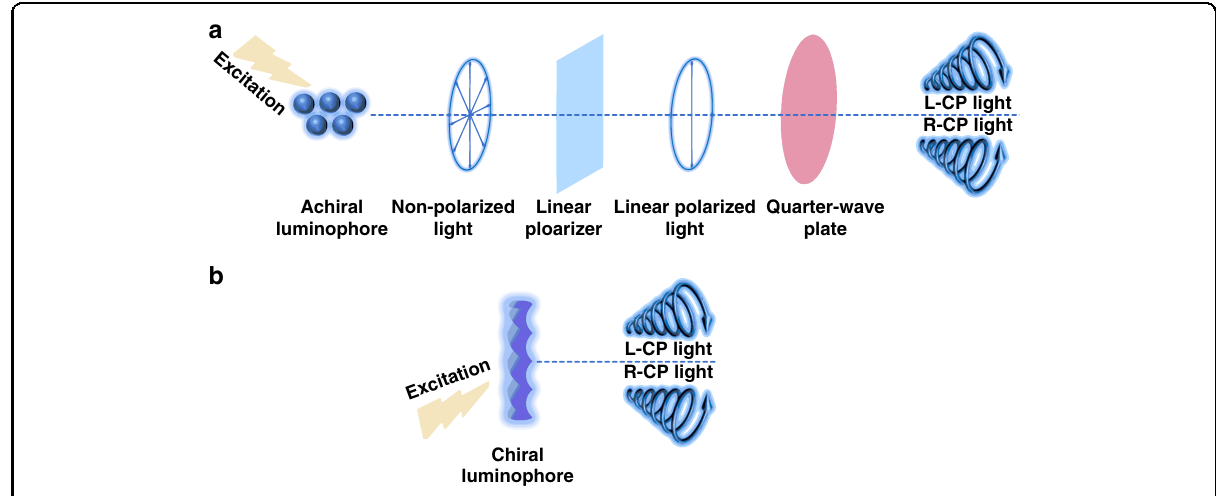
Fig. 1 Methods for generating circularly polarized light. a Physical method. b Circularly polarized